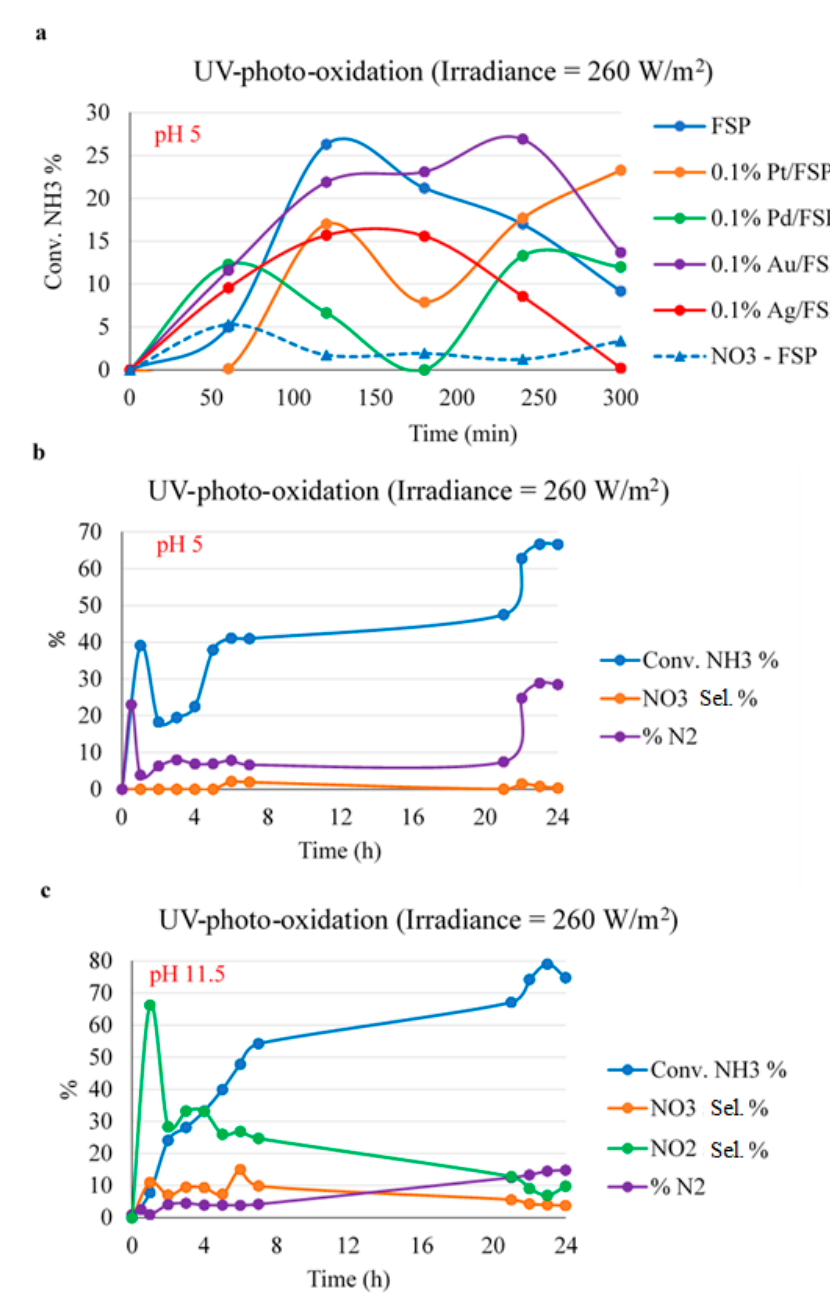
Figure 3. Activity tests under UV lamp irradiation of ( a ) bare FSP and metal-promoted photo-catalysts at pH 5, ( b ) 0.1% Pt/FSP at pH 5 for 24 h, ( c ) 0.1% Pt/FSP at pH 11.5 for 24 h. Testing at room temperature (r.t.), 60 mL/min, 4:1 ( vol / vol ) He:O 2 flow, 1 g/L of catalyst, 0.2 mol/L of NH 4 + and 250 mL of solution. Conv. NH 3 %: ammonium conversion; Sel.%: selectivity to the given product; % N 2 : N 2 percentage in the gas phase.